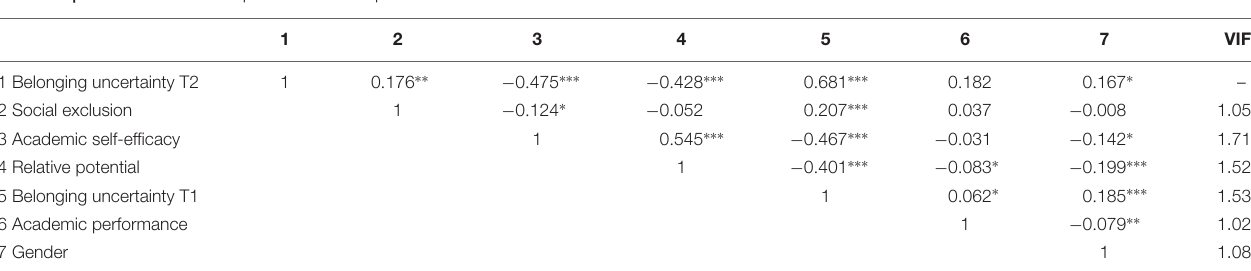
TABLE 2 | Correlations of the dependent and independent variables.